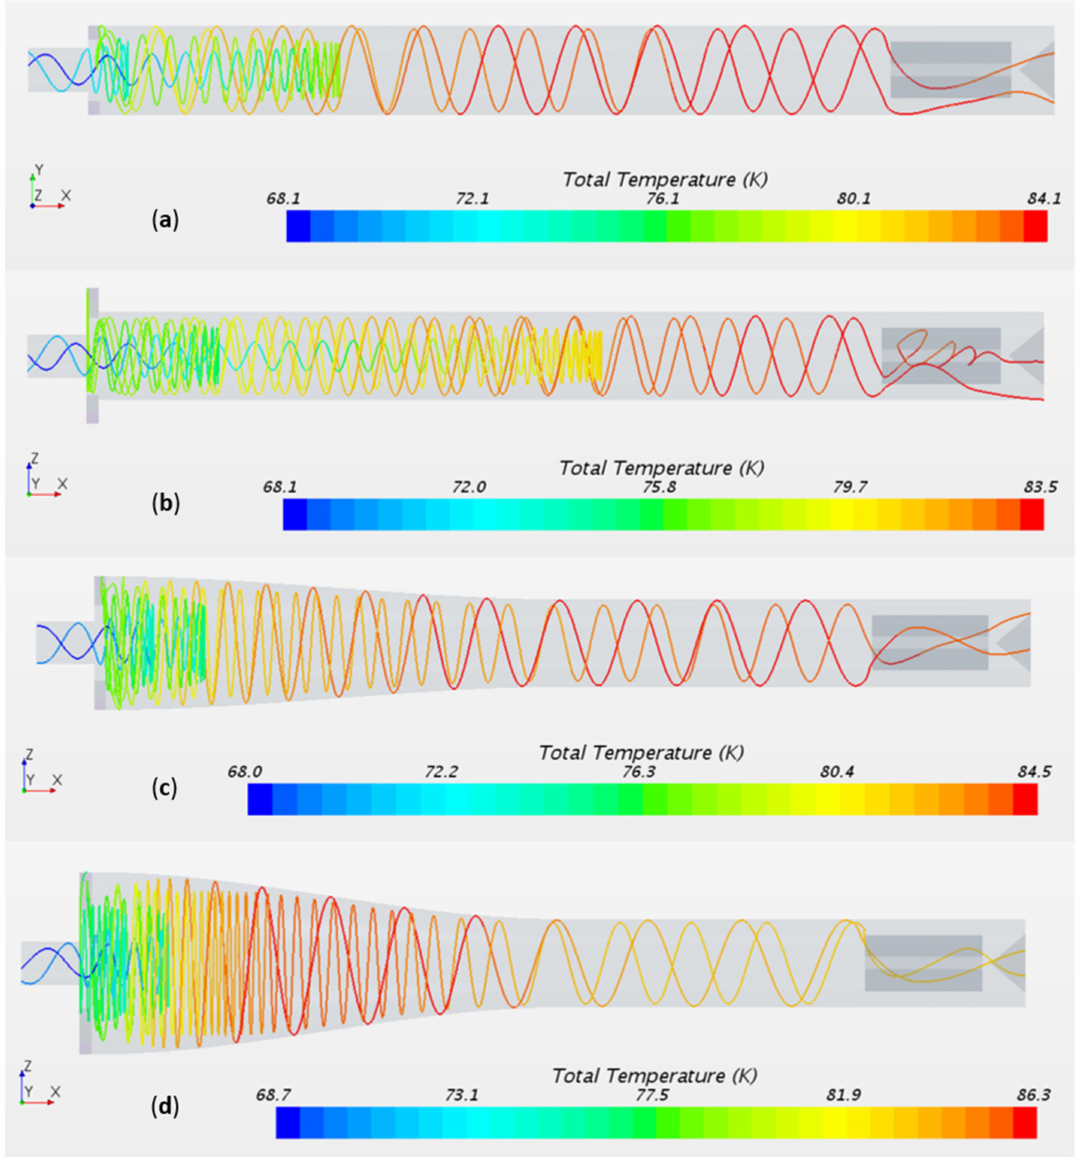
Figure 10. Vortex-tube streamlines with indicated variations of the total temperature ( a ) case A, ( b ) case B, ( c ) case C, ( d ) case